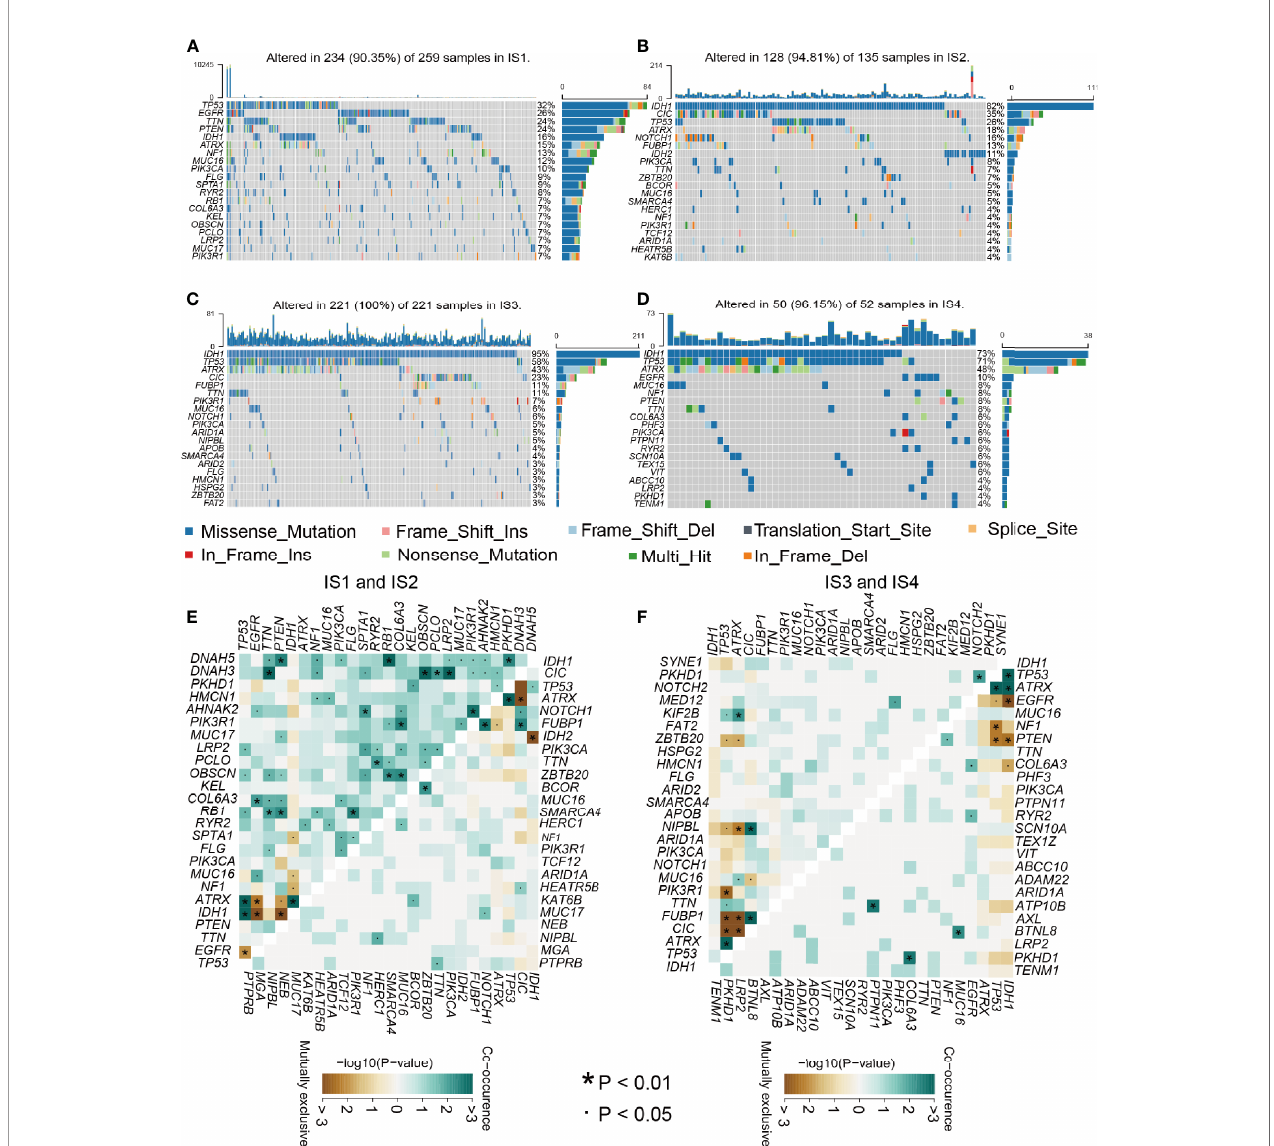
FIGURE 7 | Relationship between mutation rate and immune subtypes. (A – D) Waterfall diagram of the four immune subtypes. (E – F) Heatmap showing the mutual co-occurrence and exclusive mutations within the top 25 frequently mutated